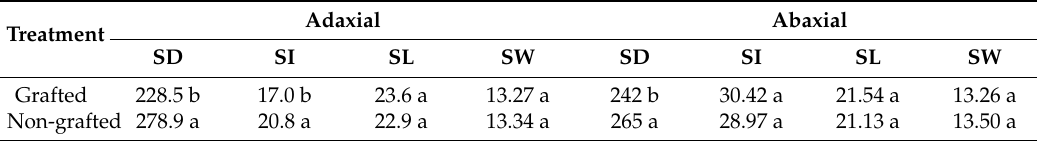
Table 6. Effect of grafting on watermelon leaf micromorphology.